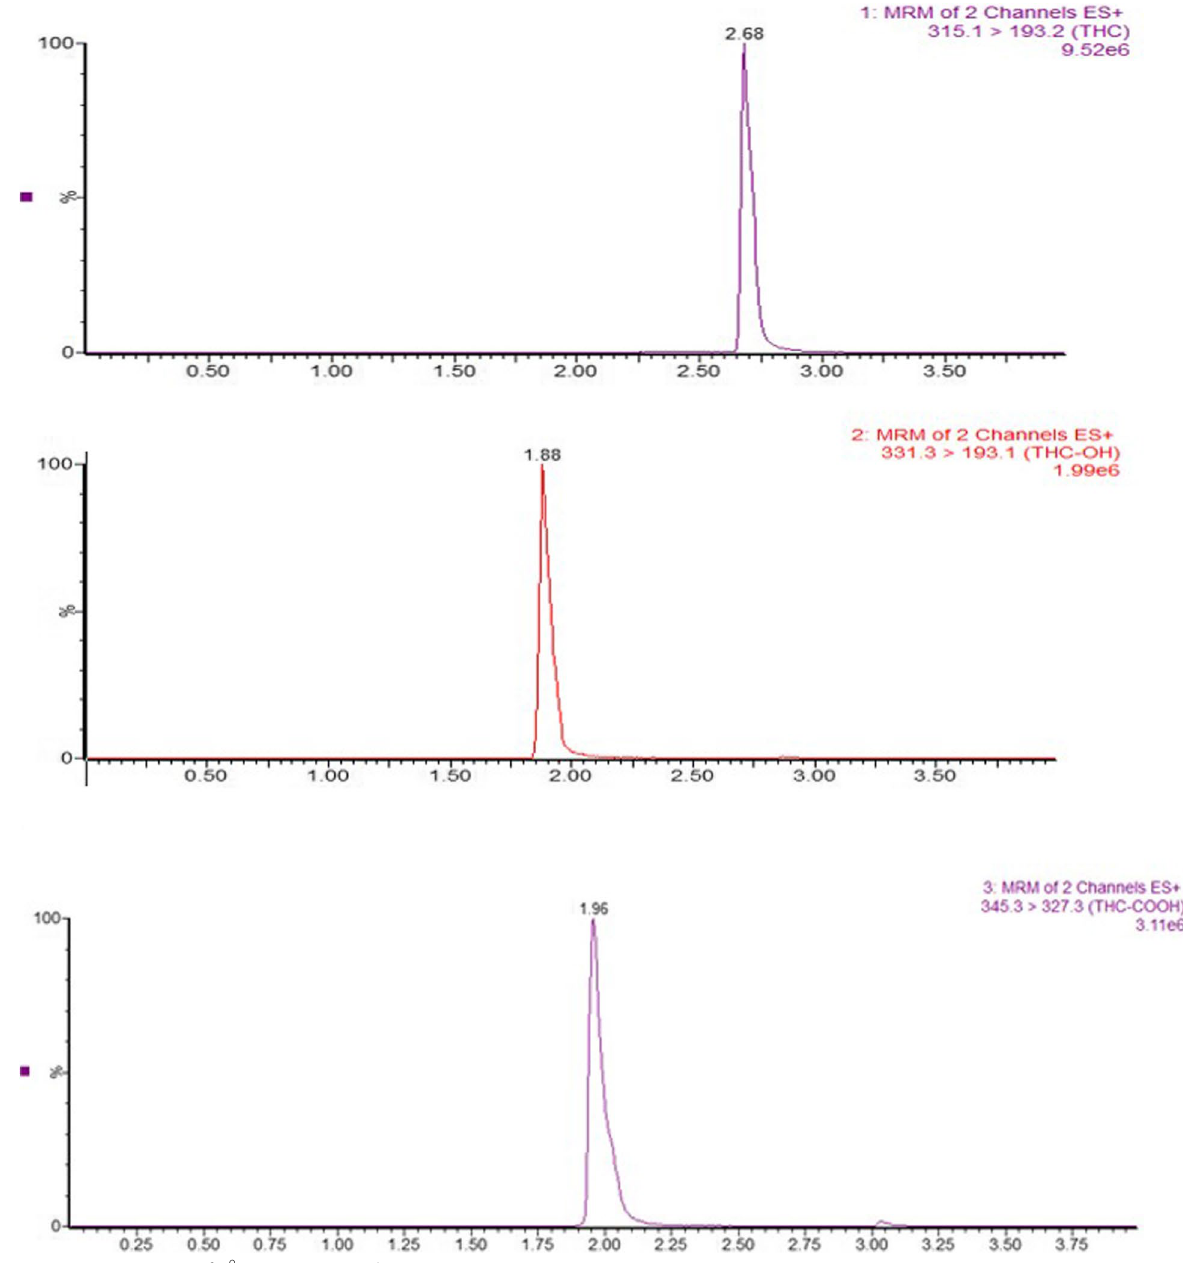
Table 1. Notably, the percentage of the administered dose of Δ 9 THC was highest in the brain and lowest in the liver, indicating that the i.n. route of